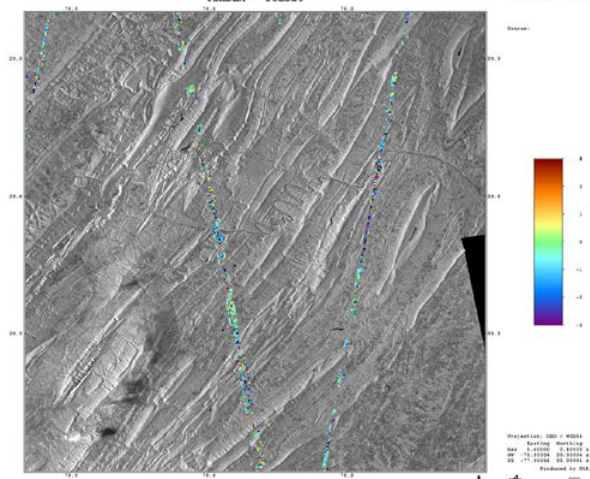
Figure 8: Difference between TanDEM-X and ICESat on amplitude mosaick, tile N39W79, range of values [-3; 3]